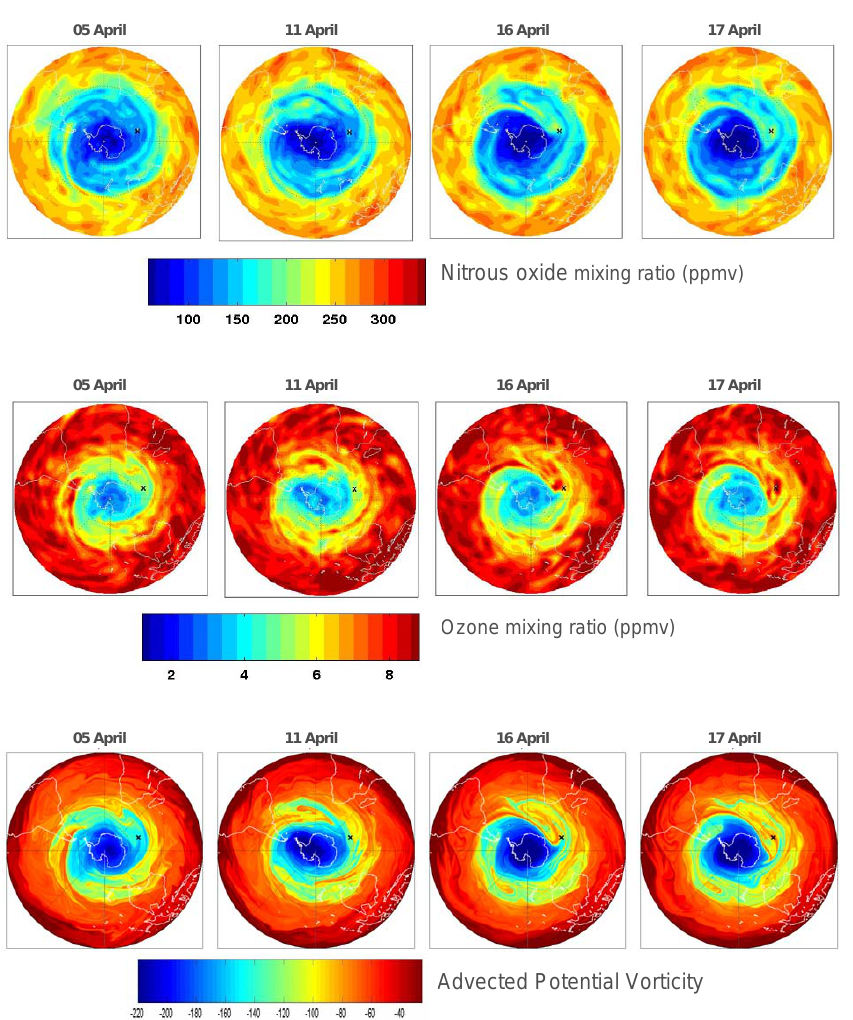
Fig. 4. Same as Fig. 3, but for the 700-K isentropic Upper plots : Maps of ozone mixing ratio (in ppmv) as derived from MOCAGE-PALM assimilation system using Aura/MLS observations, during April 2008, onto the 700-K isentropic level for selected dates: 05, 11, 16 and 17 April. Lower plots : Same as for the upper plots, but for Advected Potential Vorticity (APV) derived from the high-resolution MIMOSA model. The black cross “ × ” symbol indicates the Kerguelen location.